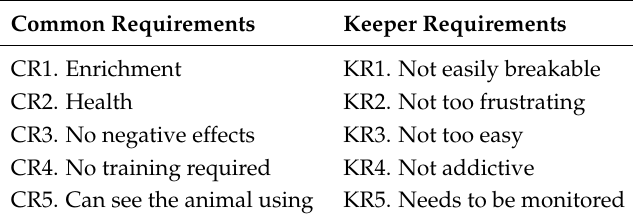
Table 1. Requirements identified from our questionnaire consisting of shared (common) requirements by visitor and keepers and keeper specific requirements. Ordering indicates descending